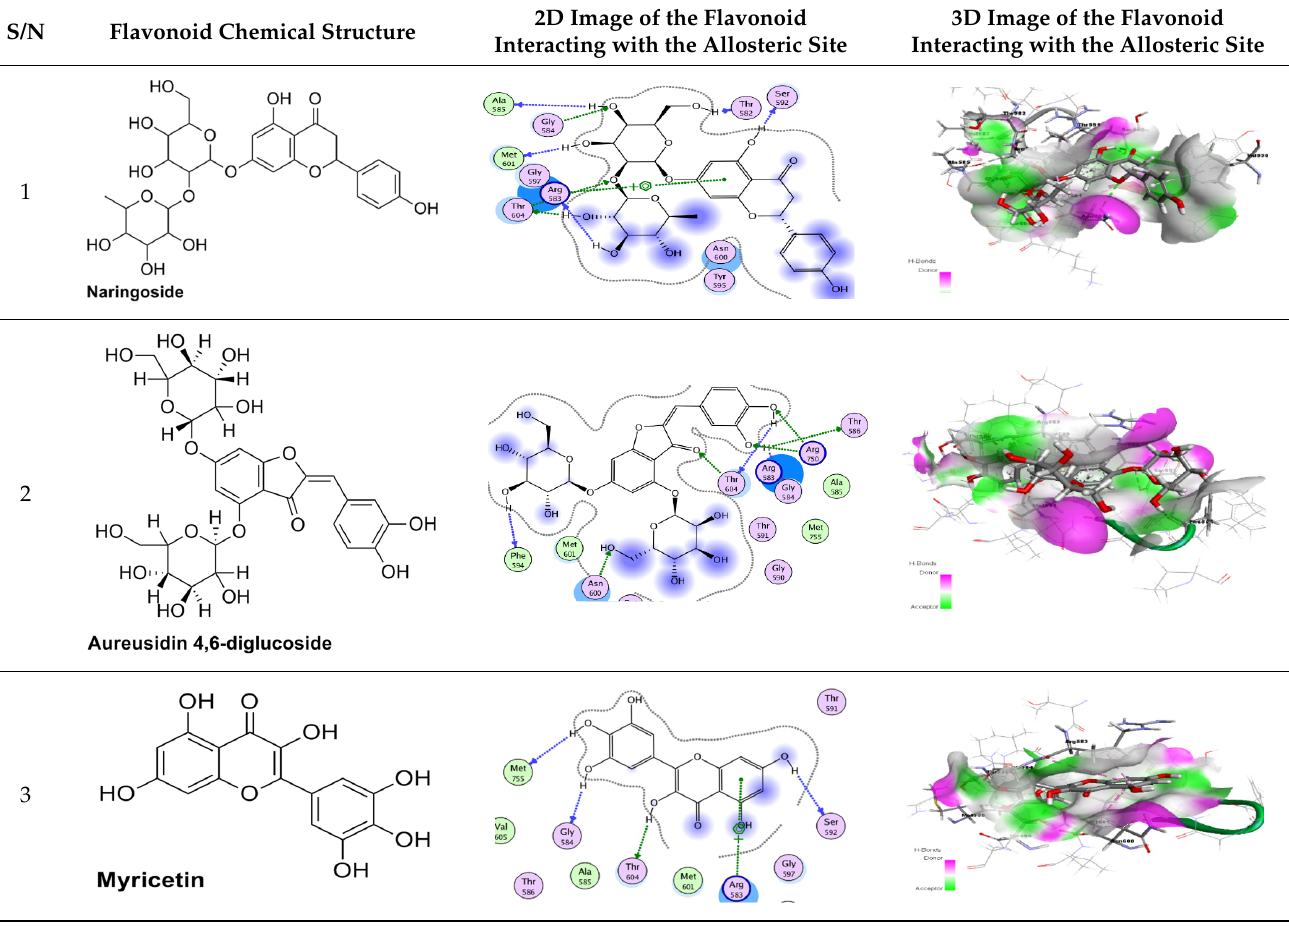
Table 1. Chemical structures, 2D and 3D images of the top three flavonoids interacting with the allosteric site residues.